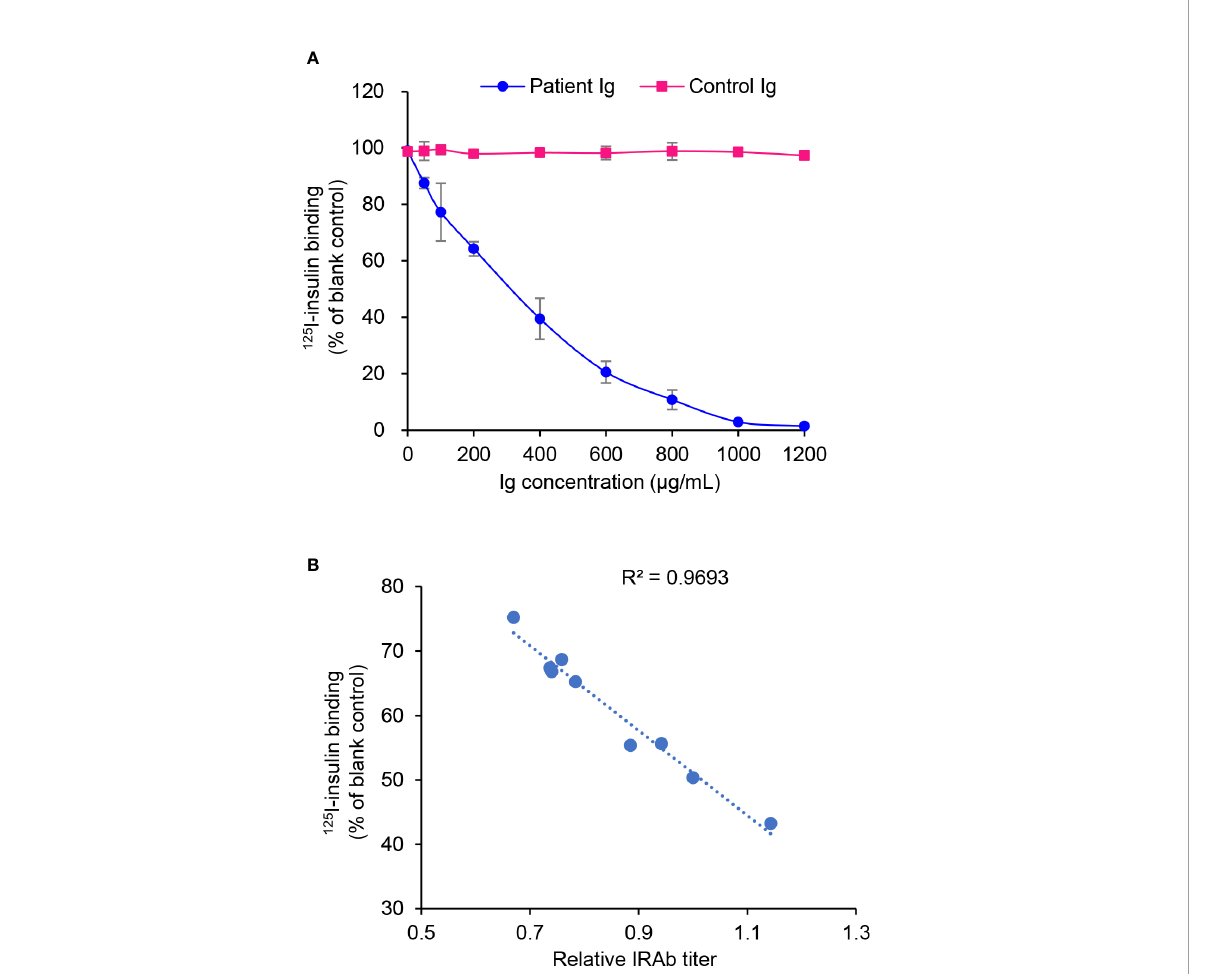
FIGURE 4 Inhibition of 125 I-insulin binding with CHO-hIR cells by patient immunoglobulins. (A) CHO-hIR cells were pre-incubated with varying concentrations of Patient immunoglobulins (Ig) or Control Ig, followed by 125 I-insulin binding assay. CHO-hIR cells without Ig pre-incubation were included as blank control and reference group. For each Ig concentration, three duplicates were set. (B) Ig were extracted from patient plasma samples collected on different dates and their inhibitory effects on 125 I-insulin binding were assessed at the concentration of 400 m g/mL. The IRAb titers were measured in these plasma samples by immunoprecipitation assay. The correlation of 125 I-insulin binding and IRAb titer was calculated